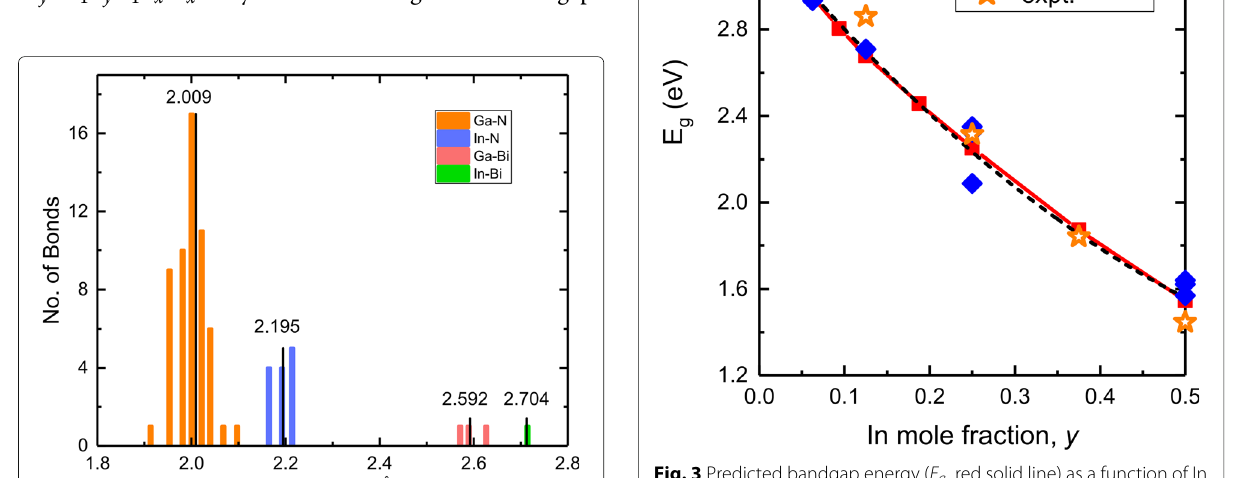
Fig. 3 Predicted bandgap energy ( E g , red solid line) as a function of In composition in In y Ga 1 − y N as well as a fit to the data (black dashed line). Other theoretical [39, 40, 46] and experimental [47–51] results are also